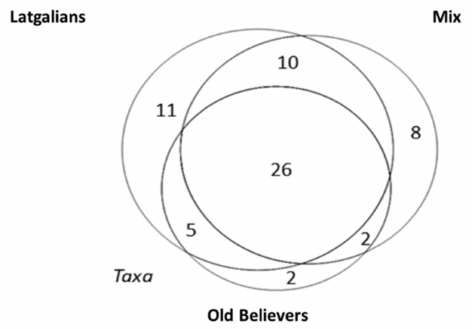
Figure 2. Overlap of taxa among the three sociocultural groups: JI Latgalians—Mix: 58%, JI Latgalians—Old Believers—55%, JI Mix—Old